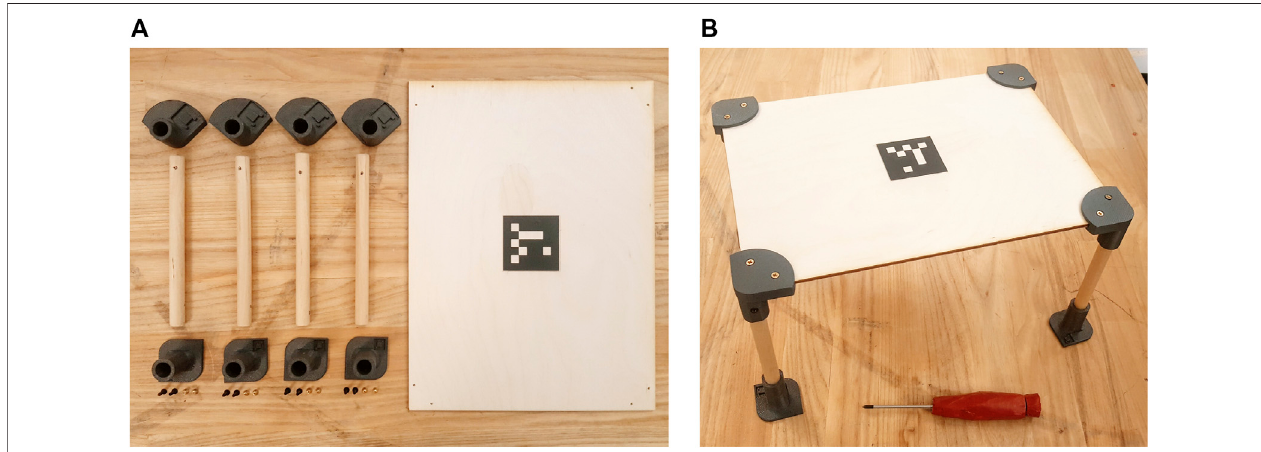
FIGURE 5 | (A) The table building task is composed of one plywood tabletop, four dowels that act as legs, four brackets (top 3D printed objects in fi gure) and four feet (bottom 3D printed objects in fi gure). A total of 16 screws are needed to secure parts together. Both the tabletop and the legs have been pre-drilled to facilitate assembly. (B) The table after the construction task is completed. The only tool required for the assembly is a screwdriver (red object in bottom of fi